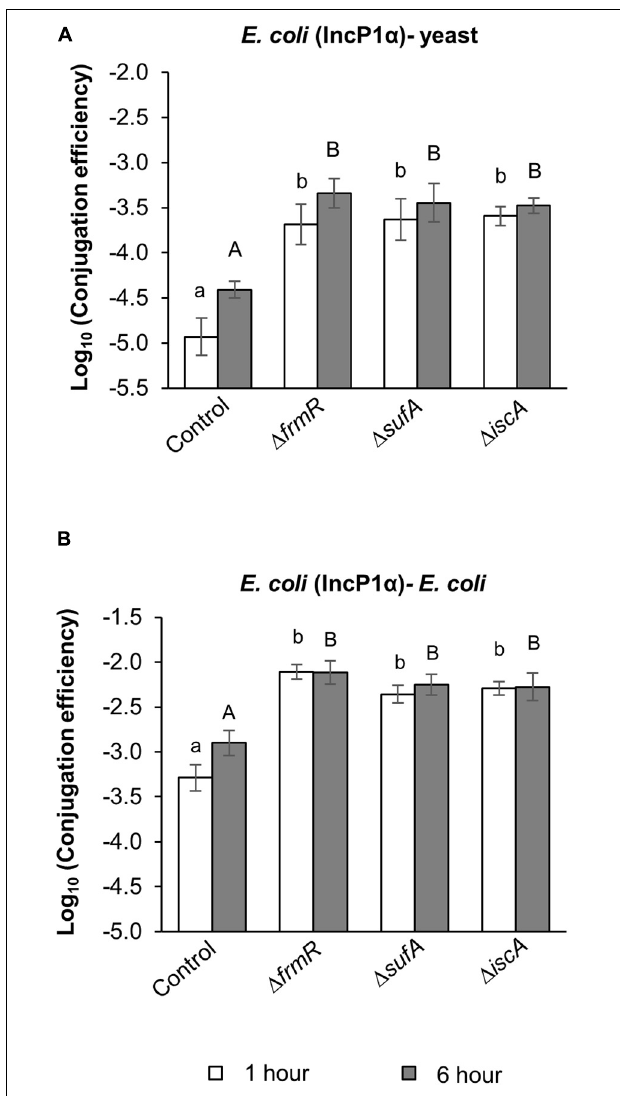
FIGURE 1 | Effect of frmR , sufA , and iscA mutations in Escherichia coli on IncP1 α conjugations. (A) TKC efficiency of IncP1 α transfer from E. coli to yeast within four experimental replicates ( n = 4). (B) Conjugation efficiency of IncP1 α transfer from E. coli to E. coli within seven experimental replicates ( n = 7). Both conjugation reactions were performed for 1 h (white bar) and 6 h (black bar). Data are presented as mean ± standard error of the mean (SEM). Different letters indicate significant differences between mutants and wild-type control at p < 0.05 using Tukey HSD multiple comparison analysis. BY4742 and SY327 were used as the recipients. BW25113 parental strain was used as the